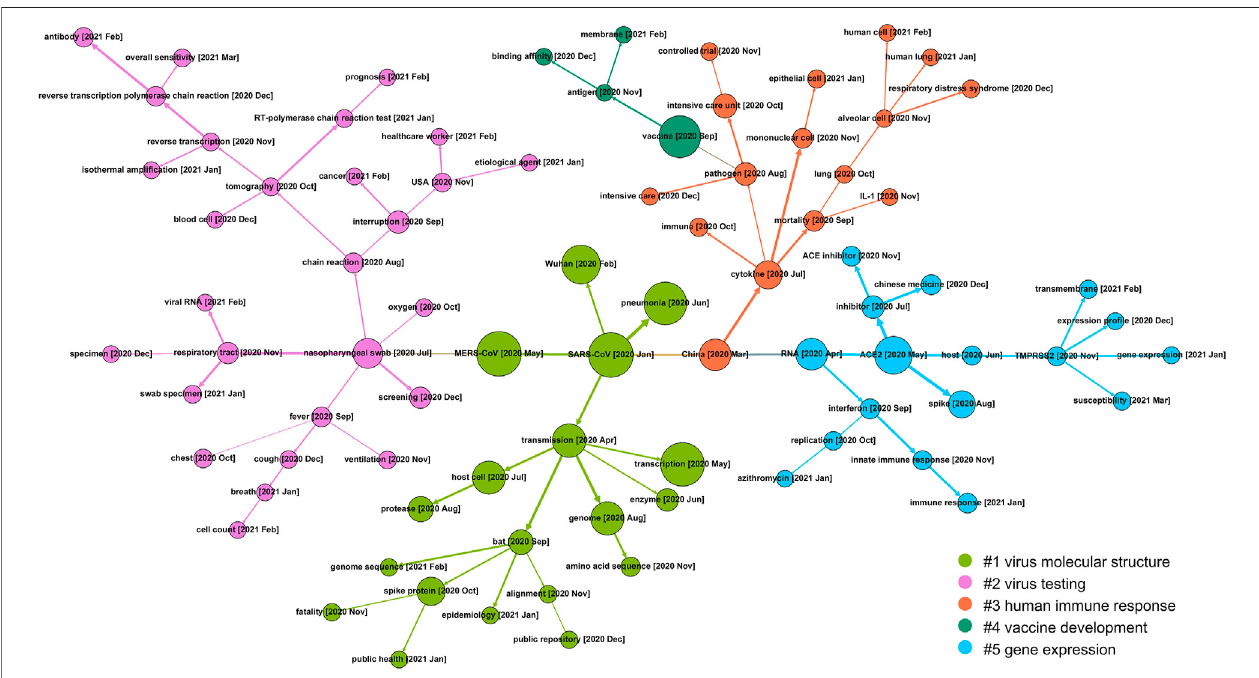
FIGURE 5 | The SEP on COVID-19 genetic research between January 2020 and April 2021.